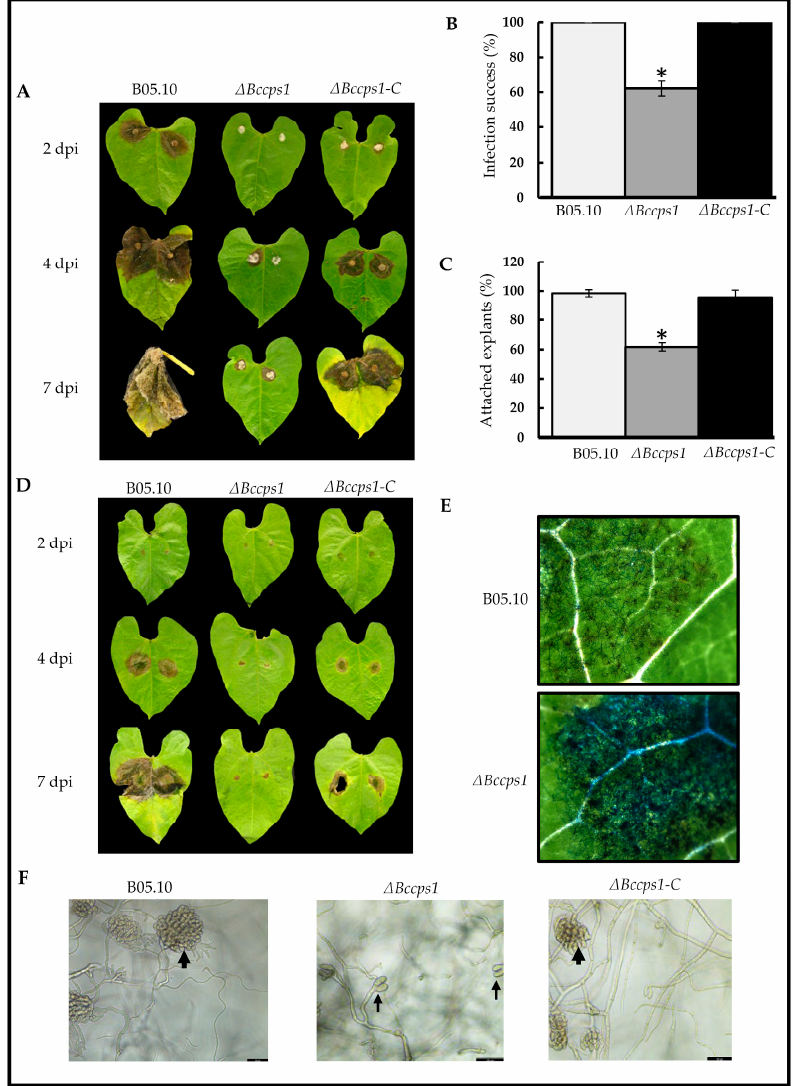
Figure 7. BcCps1 is involved in virulence. ( A ) Infection of bean leaves by mycelial explants of the parental (B05.10), mutant ( ∆ Bccps1 ) and complemented ( ∆ Bccps1 -C) strains. Photos representative of the symptoms development at 2-, 4- and 7-days post inoculation (dpi) are shown. ( B ) Counting of the explants that succeeded at initiating infection. ( C ) Counting of the explants able to attach to the plant surface. Means and standard deviations were calculated from three independent experiments ( n = 9). Stars indicate significant differences ( T -test bilateral; p < 0.01). ( D ) With conidia. ( E ) Microscopy images of leaves collected from ( D ) at 2 dpi and colored with cotton blue to visualize fungal hyphae. ( F ) Development of infection cushions (large arrows) at 48 h of hyphal growth on plastic or glass surfaces in the parental and complemented strains. Development of hooks (thin arrows) in the mutant strain. Scale bars: 50